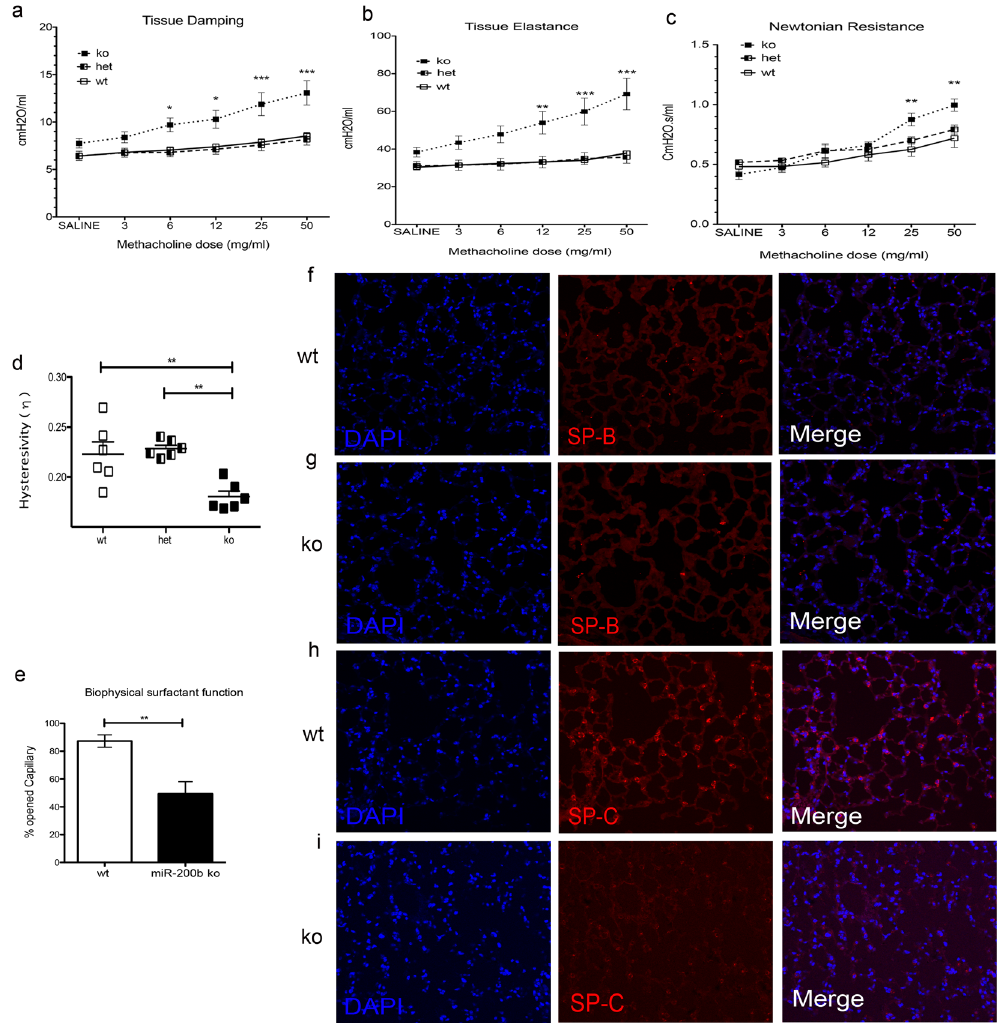
Figure 2. miR-200b is required for normal lung function. ( a ) Lung mechanics studies performed on 8-week-old mice demonstrated that miR-200b − / − (ko) mice have higher lung tissue resistance (damping) when challenged with 6 mg/ml methacholine or higher ( b ) miR-200b ko mice have higher lung tissue stiffness (Elastance) at 12, 25 and 50 mg/ml of methacholine ( c ) and more conducting airway resistance at high concentrations of methacholine. ( d ) Accessing lung hysteresivity at the time of saline challenge (before methacholine challenge) showed lower hysteresivity in miR-200b ko mice. * P < 0.05, ** P < 0.01, *** P < 0.001, two-way ANOVA. Data represent mean ± SEM of at least six independent experiments. ( e ) Biophysical surfactant function of miR-200b ko lungs (8-week-old) measured using capillary surfactometry. MiR-200b − / − mice have decreased surfactant function compared to wt. ** P < 0.01, Student’s t-test, Data represent mean ± SEM of at least three independent experiments. ( f , g ) Immunofluorescence of 8-week-old wt ( f ) and ko ( g ) lungs showed decreased abundance of Surfactant Protein-B (SP-B) in ko lungs. ( h , i ) Immunofluorescence of 8-week-old wt ( h ) and ko ( i ) lungs showed decreased abundance of pro-Surfactant Protein-C (SP-C) in ko